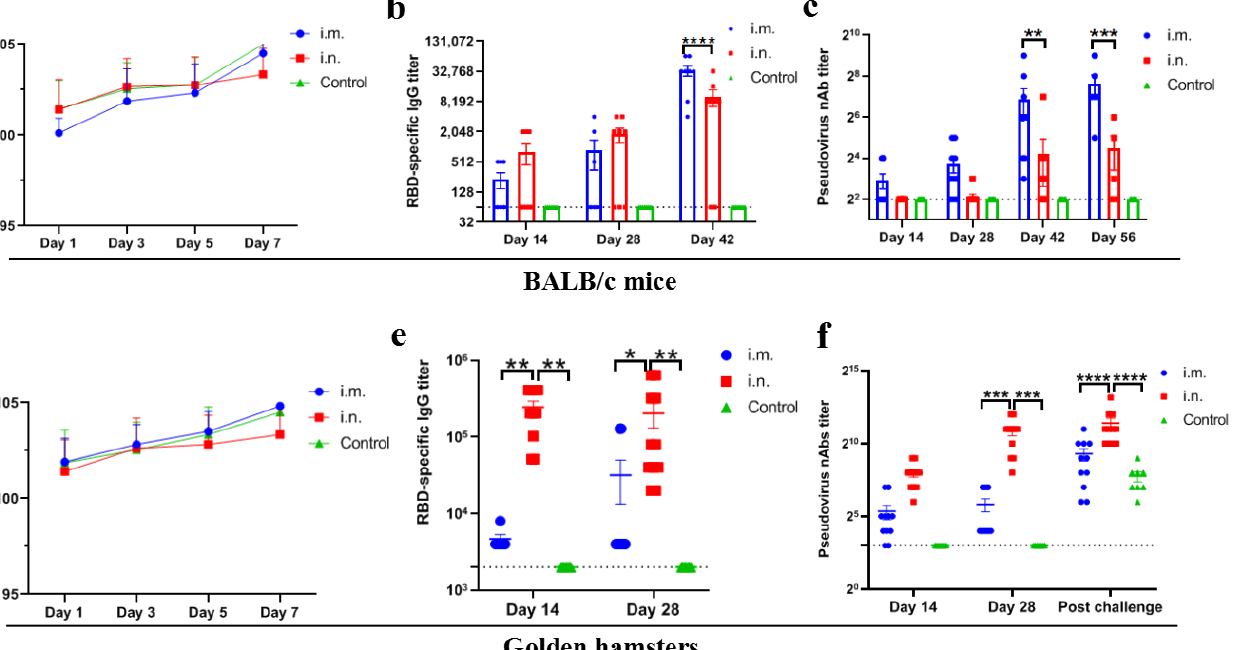
Figure 3. Antibody subtype and cytokines induced by rVSVΔG-S in BALB/c mice. I.m., i.n. and con- trol refer to i.m. ( n = 4), i.n. inoculation group ( n = 4) and PBS inoculation control group ( n = 2),